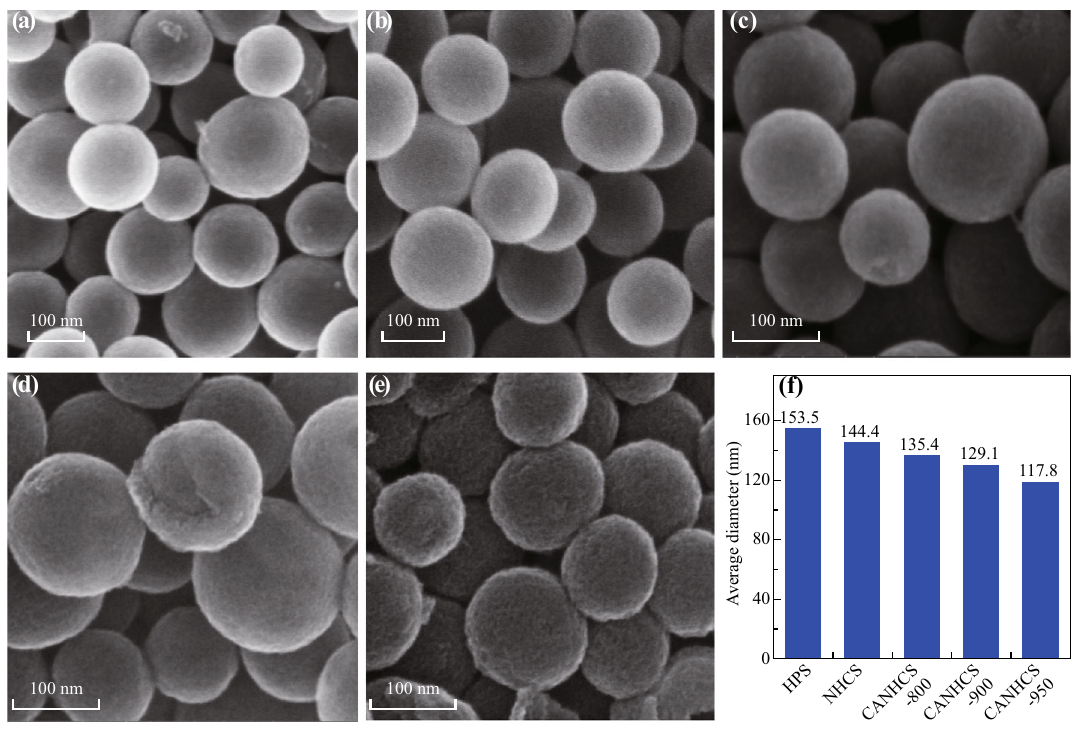
Fig. 3 SEM images of a HPSs, b NHCSs, c CANHCS-800, d CANHCS-900, e CANHCS-950 and f average diameters of carbon spheres calculated from panel a – e